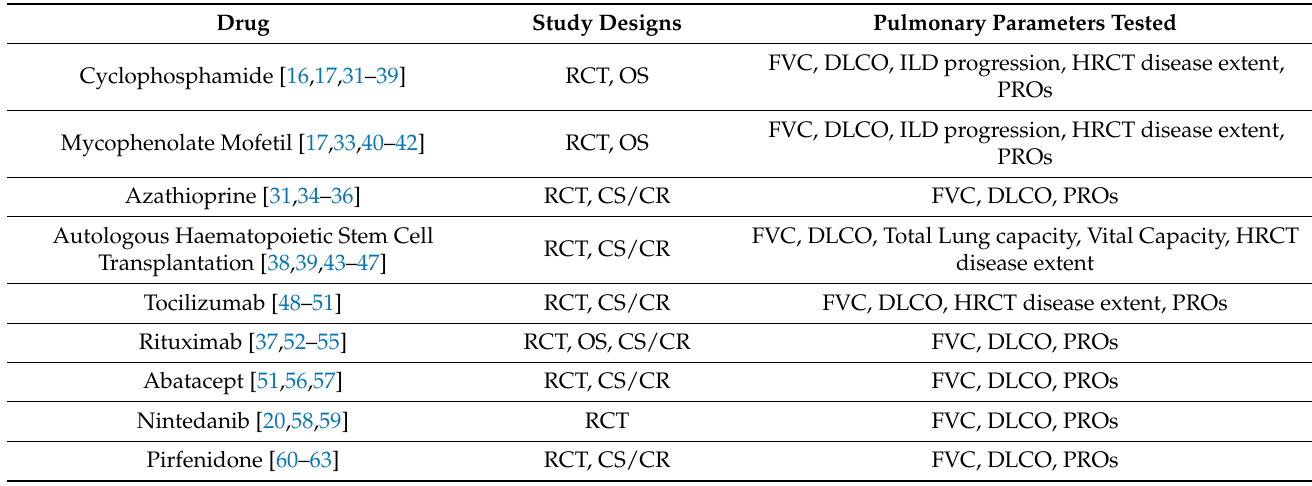
Table 1. Summary of current treatment options for systemic sclerosis related interstitial lung